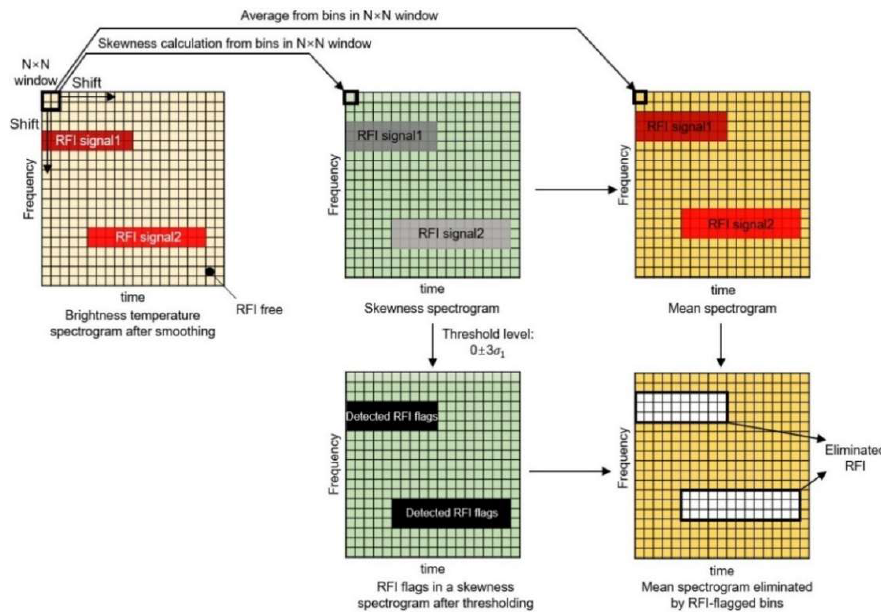
Figure 2. Process of obtaining the spectrograms of RFI-contaminated signals corresponding to each procedure in Step 1.